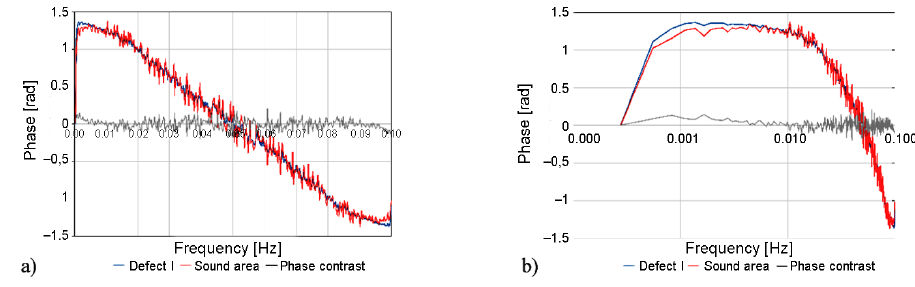
Fig. 15. Phase spectra of transient curves, BM 3-1, bottom surface, distance 1.5 m; a) linear scale, b) logarithmic scale